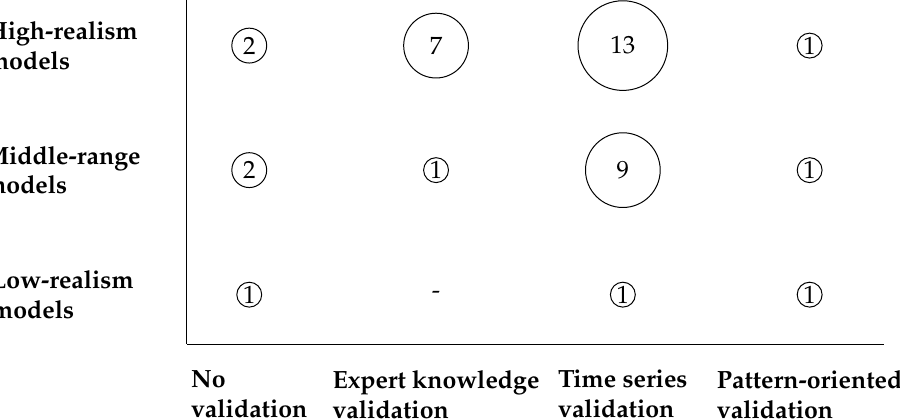
Figure 4. Number of models sorted by their degree of realism and the chosen validation approach. Some models are validated using multiple approaches; hence, the numbers in the graphic add up to over 35